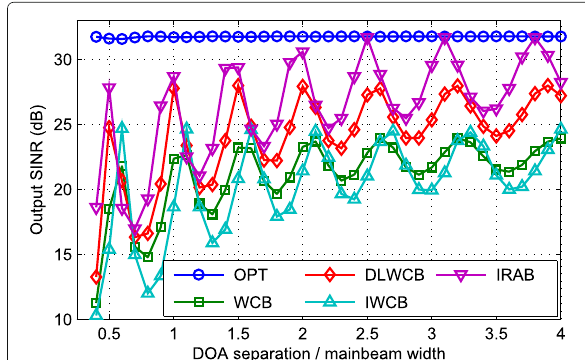
Fig. 12 SINR versus DOA separation: M=15, mainbeam width=16 ◦